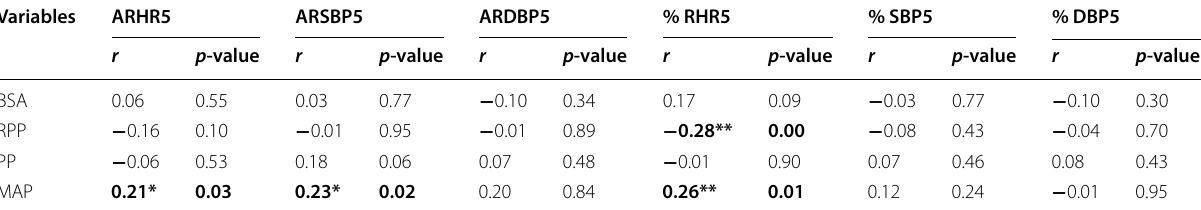
Table 4 Relationship between body surface area, derived cardiovascular indices, and blood pressure/heart rate recovery 5 min after removal of exercise stimulus